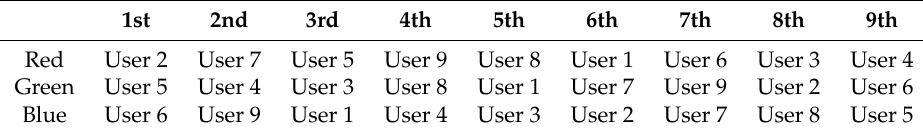
Table 3. Data flow in this demonstration. Orders are naturally established based on their